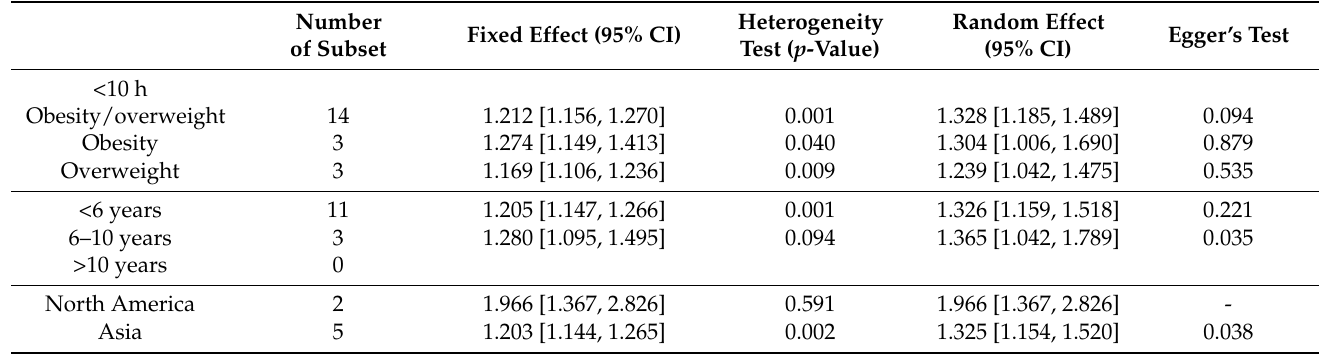
Table 3. Meta-analysis for the odds ratio of obesity/overweight according to the sleep